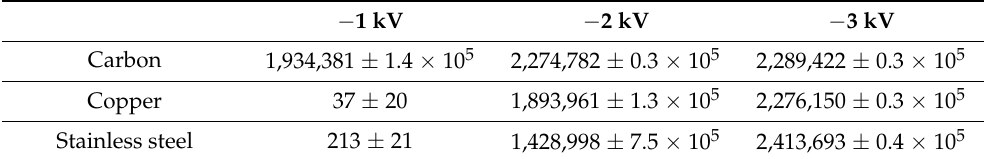
Table 1. Average ion amount generated by material and voltage.